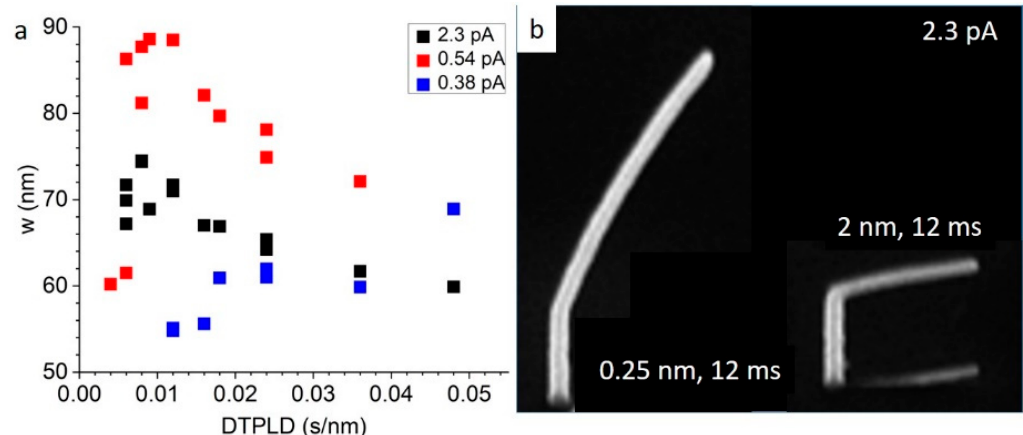
Figure 3. ( a ) Plot of w as a function of the dwell time per lateral displacement (DTPLD) (s nm − 1 ), for beam energy of 25 keV, beam currents of 0.38 pA, 0.54 pA and 2.3 pA, and a precursor chamber pressure of 1 × 10 − 5 Torr. ( b ) Example of two pillars bending in segments grown at 25 keV, 2.3 pA, with 12 ms dwell time, and 0.25 nm and 2 nm pixel pitches, respectively.